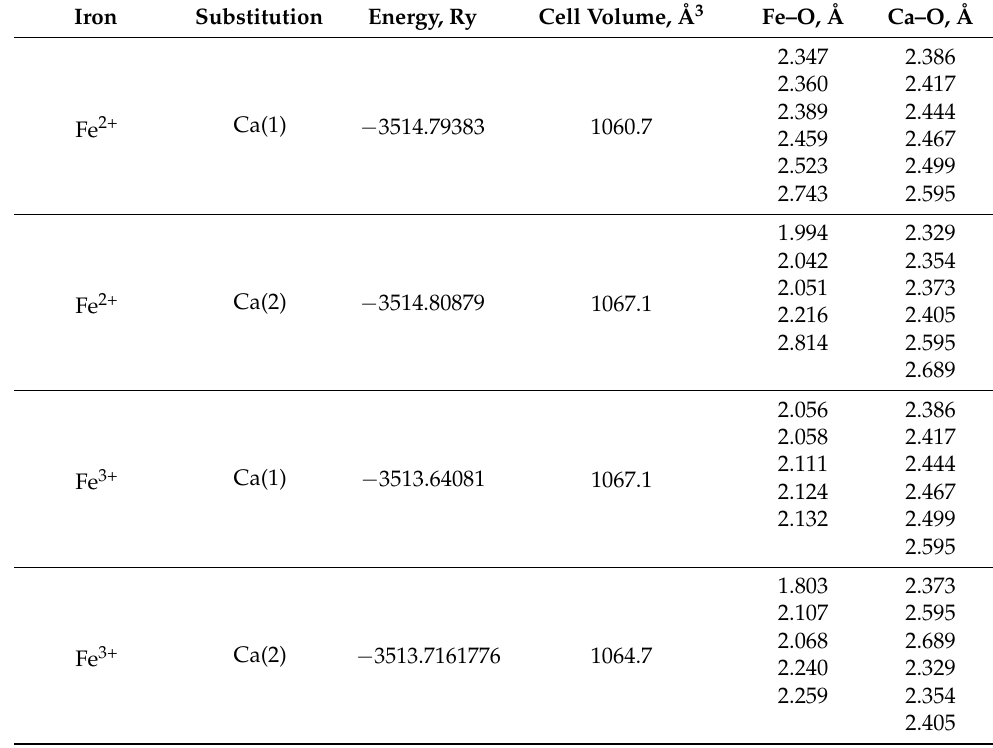
Table 1. Some calculated parameters of the HAp supercell for Ca 9.5 Fe 2+ 0.5 (PO 4 ) 6 (OH) 2 with ferrous cation (Fe 2+ ) and Ca 9.5 Fe 3+ 0.5 (PO 4 ) 6 O 2 H 1.5 with ferric cation (Fe 3+ ). The length of the Ca–O bonds is given for pure